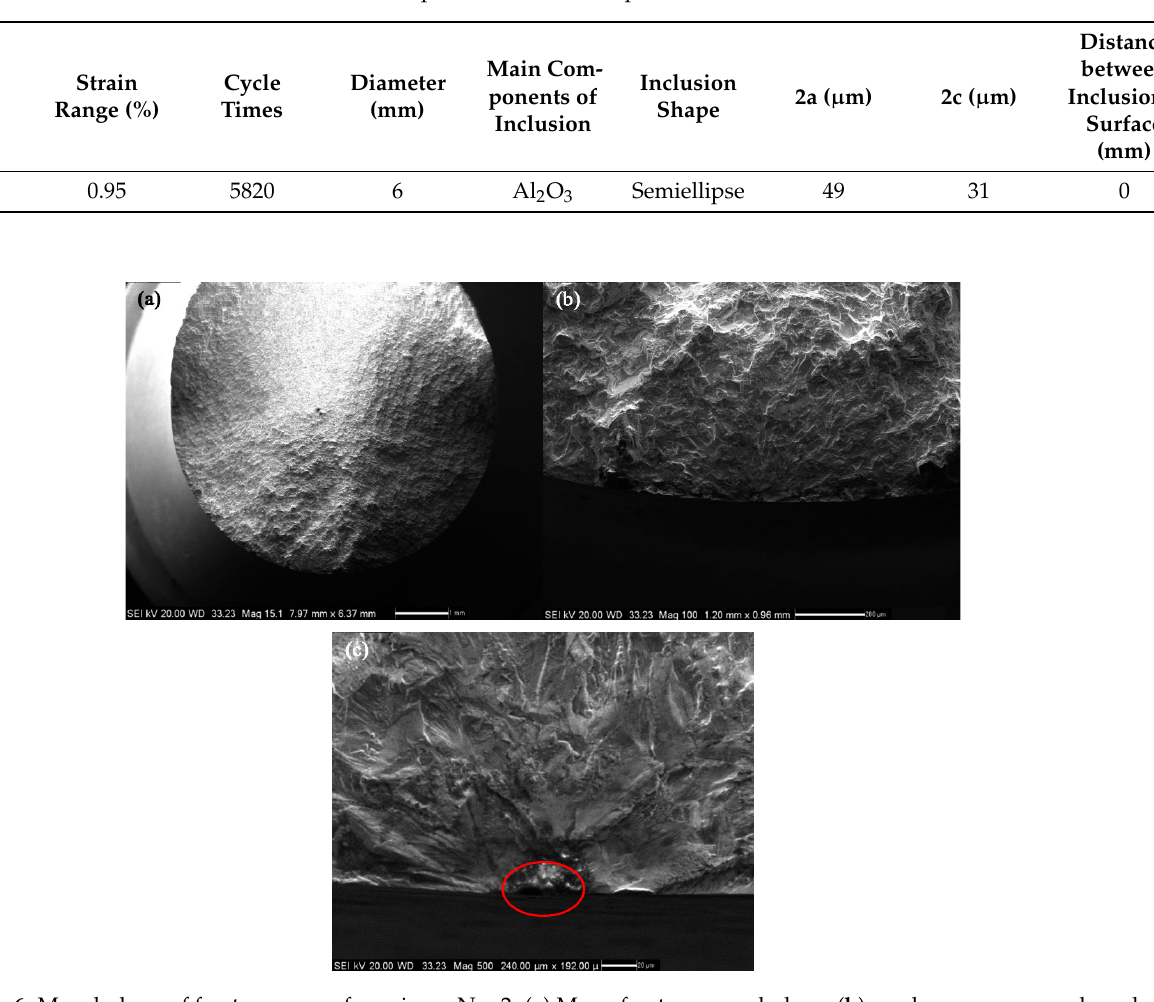
Figure 7. Fracture defect energy spectrum of specimen No. 2. By analyzing the stress cloud chart shown in Figure 8, it is evident that the maximum stress was calculated at the top of the inclusion when there is no debonding at the matrix- inclusion interface. The stress concentration here, however, leads to the initiation of cracks. Following the occurrence of cracks, the stresses at the interface with the original stress concentration are released, which reduces the stress level at the interface. The stress concentration shifted to the crack tip of the interface between the inclusion and matrix, making it a driving force of crack propagation. As the specimen continues to be loaded, the cracks gradually propagated along the interface and finally entered the matrix mate- rial, leading to the fatigue failure of the specimen.